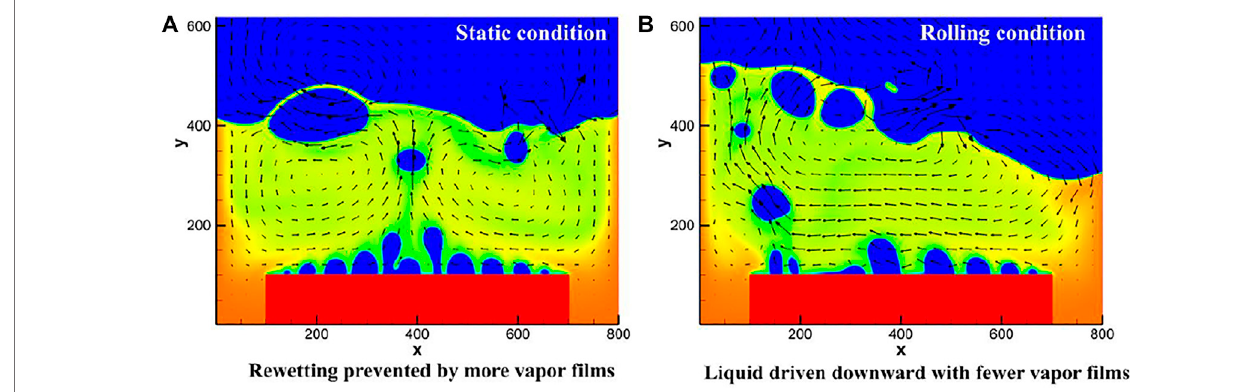
FIGURE 10 | Velocity vector diagram of pool boiling at CHF under static and rolling conditions.